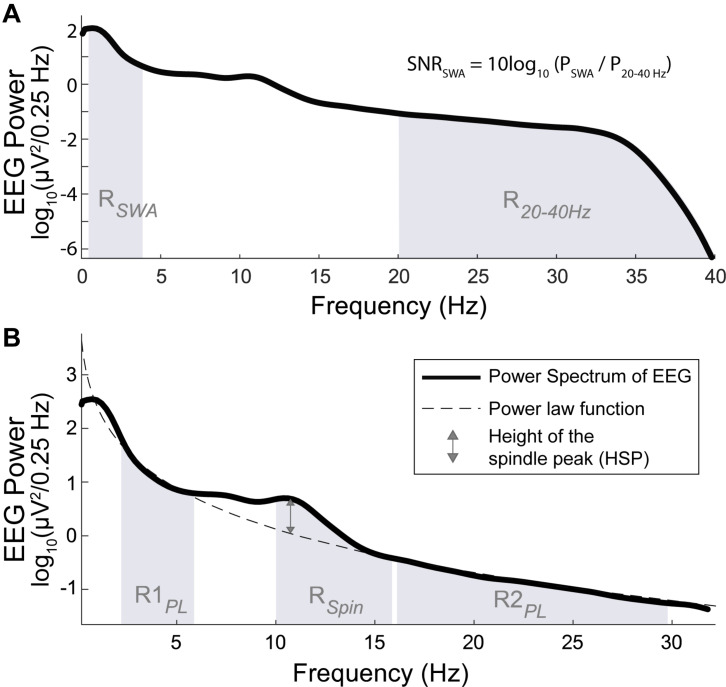
Power spectrum (bold line) across all artifact free N2 and N3 sleep epochs of one individual. (A, top) The SNR of SWA (SNRSWA) is calculated by the power ratio of the SWA frequency range RSWA (shaded region between 0.5 and 4 Hz) with respect to the frequency range of no interest, R2040 Hz (shaded region between 20 and 40 Hz). (B, bottom) The height of the spindle peak (HSP, double sided arrow) is calculated relative to the background spectrum obtained by the power law function (dashed line) fitted to the respective background power spectrum in the R1PL (shaded region between 2 and 6 Hz) and R2PL frequency range (shaded region between 16 and 30 Hz), excluding the 6–16 Hz range (which included RSpin, shaded region between 10 and 16 Hz).